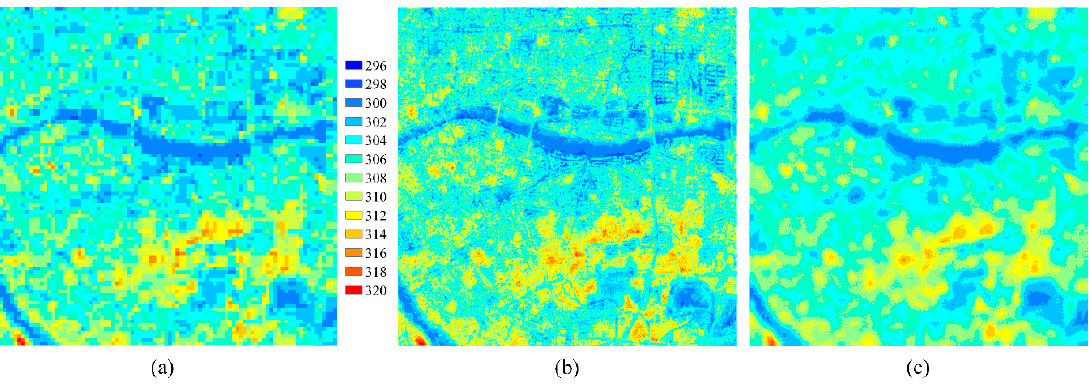
Figure 8 . Spatial distribution of LSTs in region A. ( a ) 90 m ASTER LST; ( b ) 10 m RFATPK LST; and ( c ) 10 m TsHARP LST.